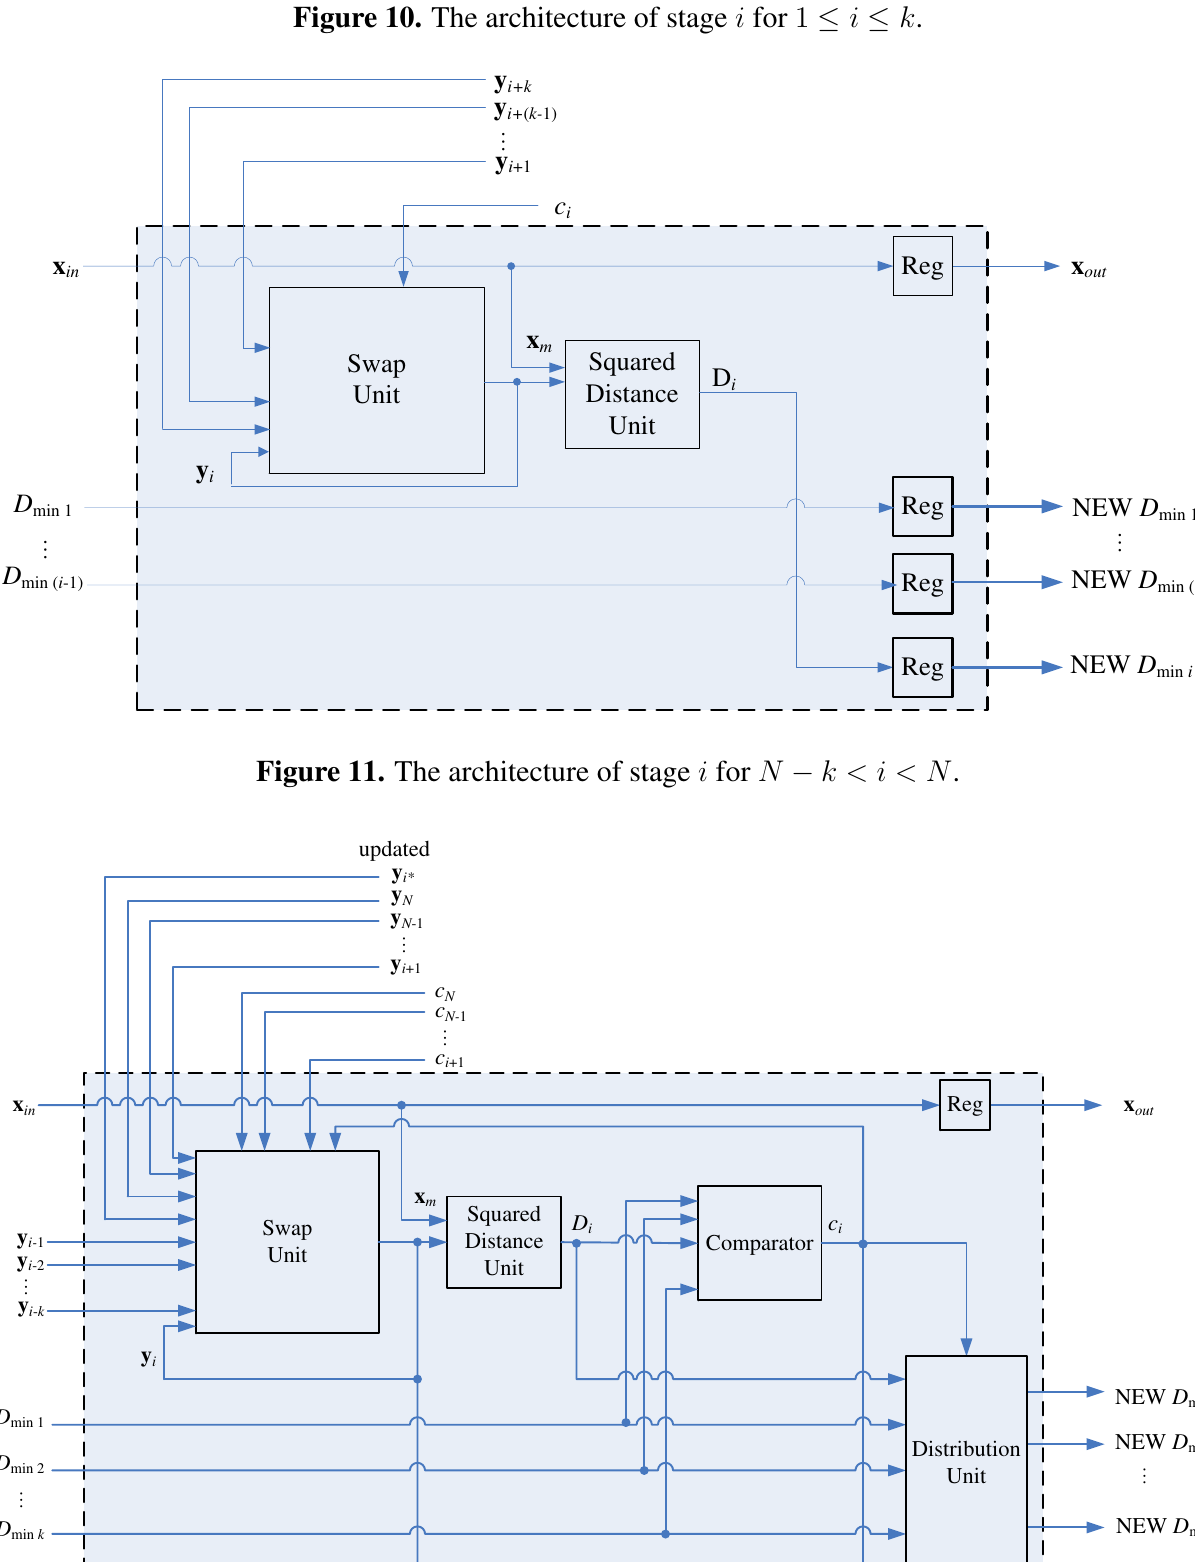
Figure 10. The architecture of stage i for 1 ≤ i ≤ k .